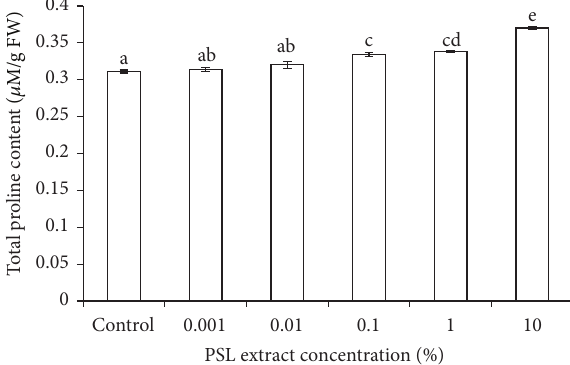
Figure 6: Effect of PSL extract on total proline content of wheat. ErrorbarsrepresentMean ± S.Dofthreedifferentexperiments.Data were subjected to one-way ANOVA analysis and differences among treatments were determined by Tukey’s test. Different letters mean statistical differences at 𝑃 < 0.05